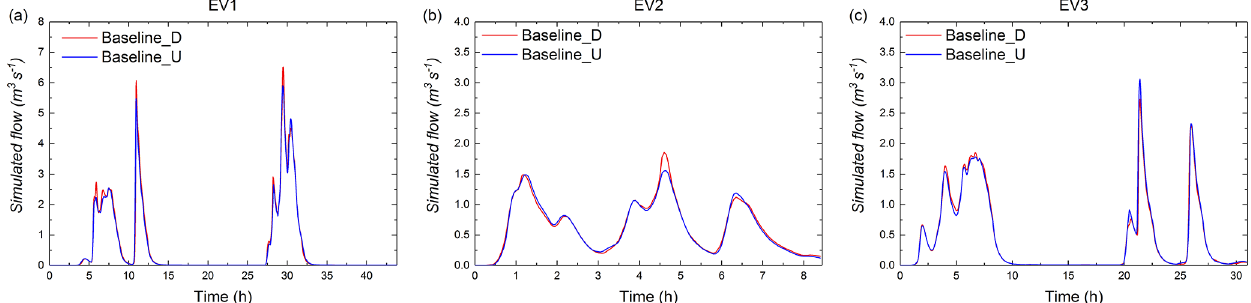
Figure 11. Simulated flow (cubic metres per second) of the baseline scenario under three distributed rainfall events and three uniform rainfall events, namely (a) EV1, (b) EV2, and (c)